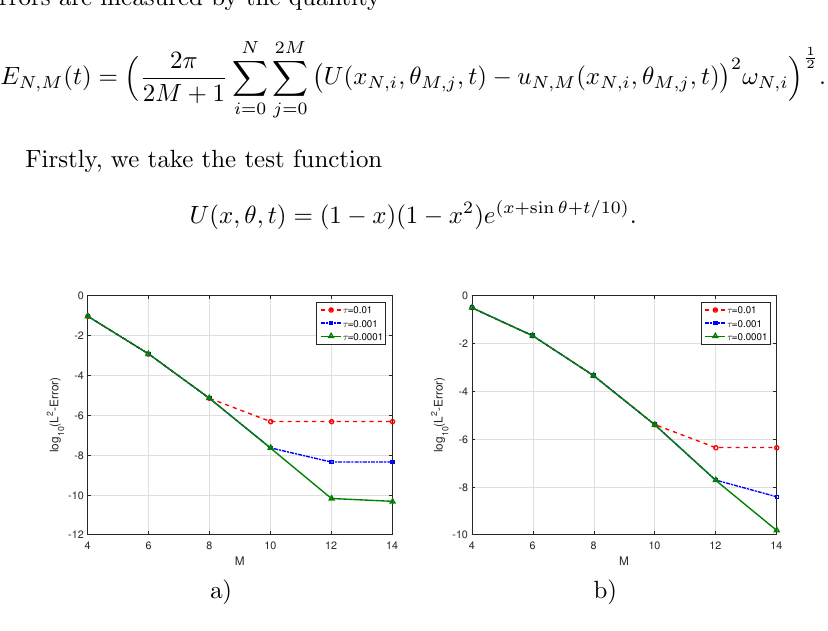
Figure 1. L 2 − errors against M , N ( M = N ) with t = 1: a) ν = 1, b) ν = 0 . 001. We sketch the L 2 − errors with t = 1 , τ = 0 . 01 , 0 . 001 , 0 . 0001, ν = 1